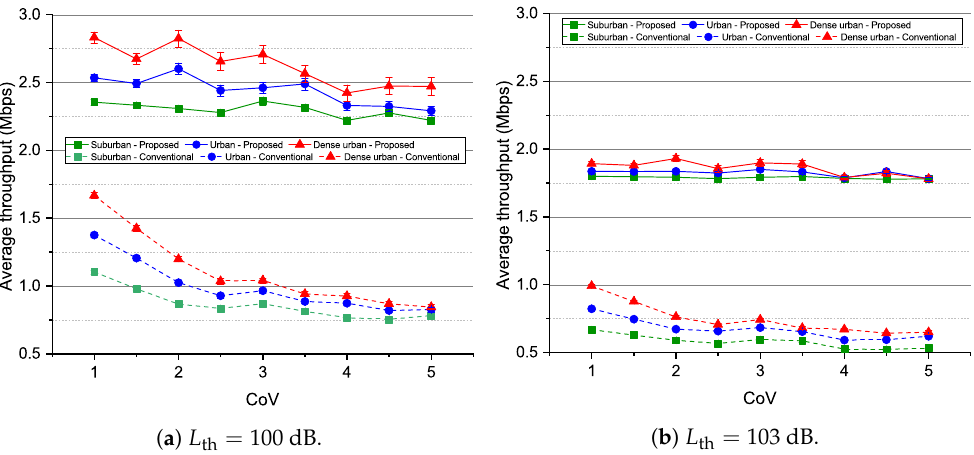
Figure 7. Average throughput versus the CoV for different urban environments and threshold path